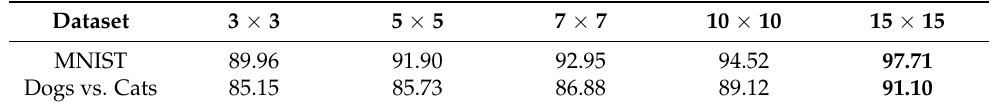
Table 10. Non-uniform attack